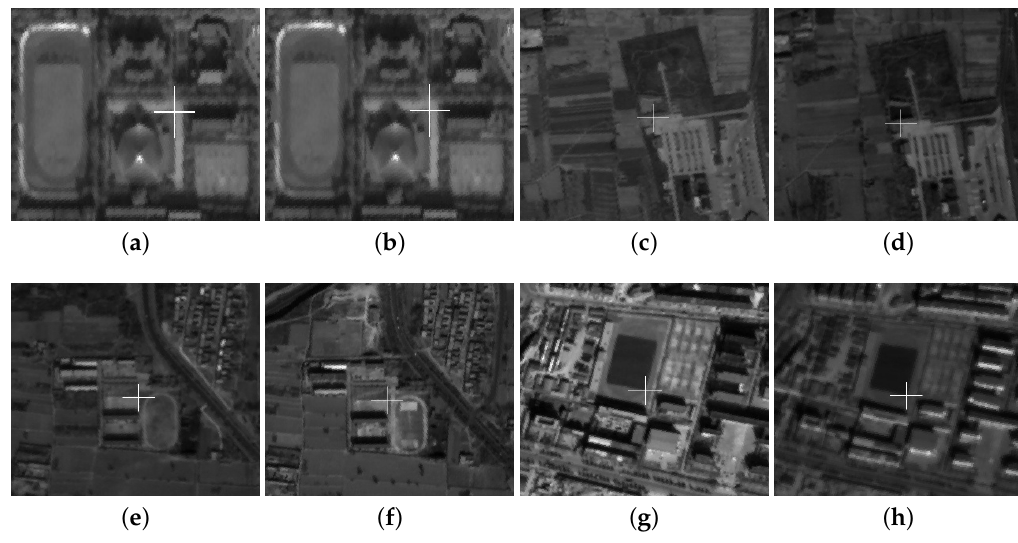
Figure 6. Examples of tie point sets. ( a , b ) are two examples of the extracted image-space points from different images in tie point set P14, where the centers of the crosses are the extracted image-space point correlated with the object in object-space. ( c , d ) are two examples of the extracted image-space point from different images in tie point set P22, ( e , f ) are two examples of the extracted image-space point from different images in tie point set P34, and ( g , h ) are two examples of the extracted image-space point from different images in tie point set